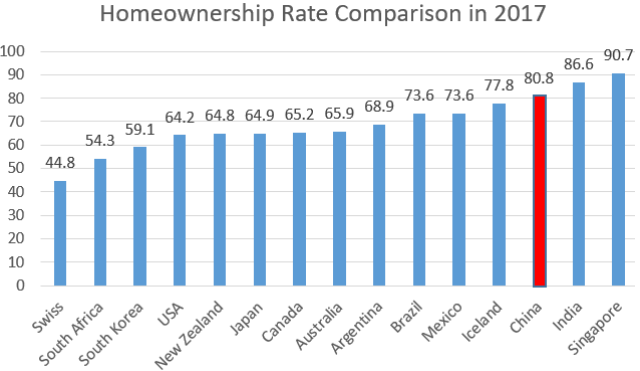
Fig. 4. Homeownership rate comparison among countries in 2017 (Gan, 2017, p. 2).